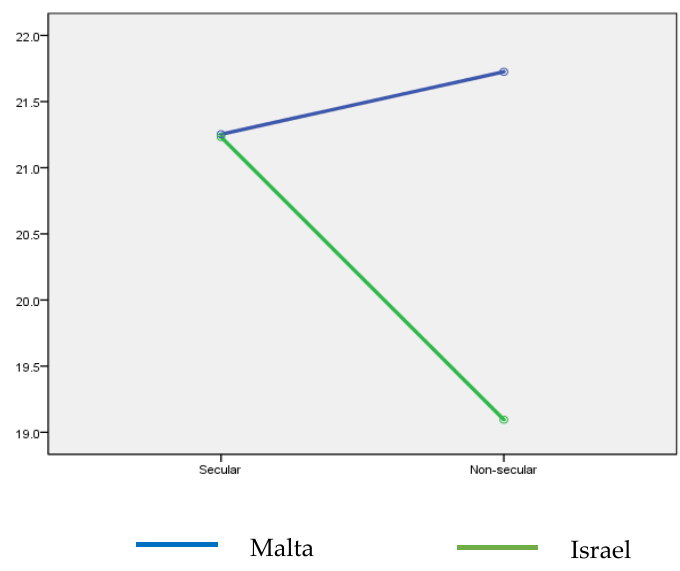
Figure 1. Fear of COVID-19 by country and religiosity.